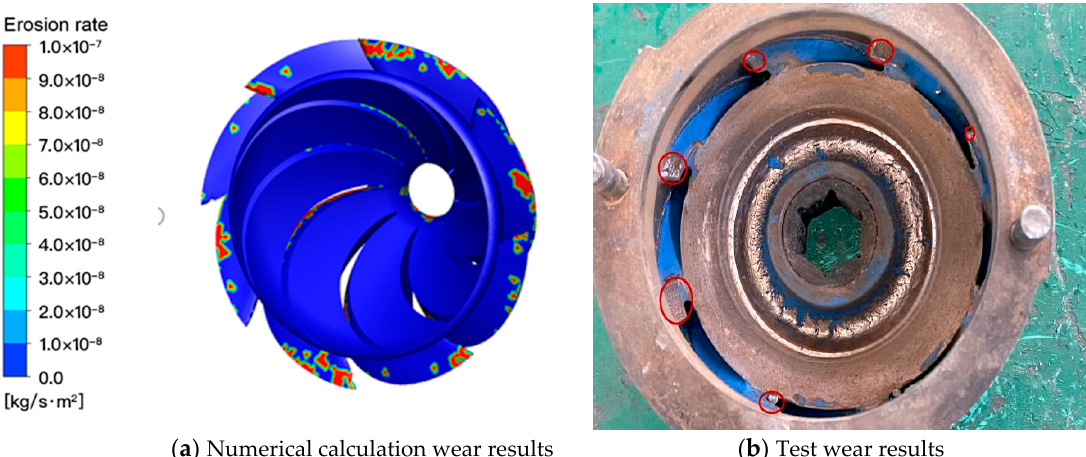
Figure 28. Comparison of the wear at the first stage guide vane.